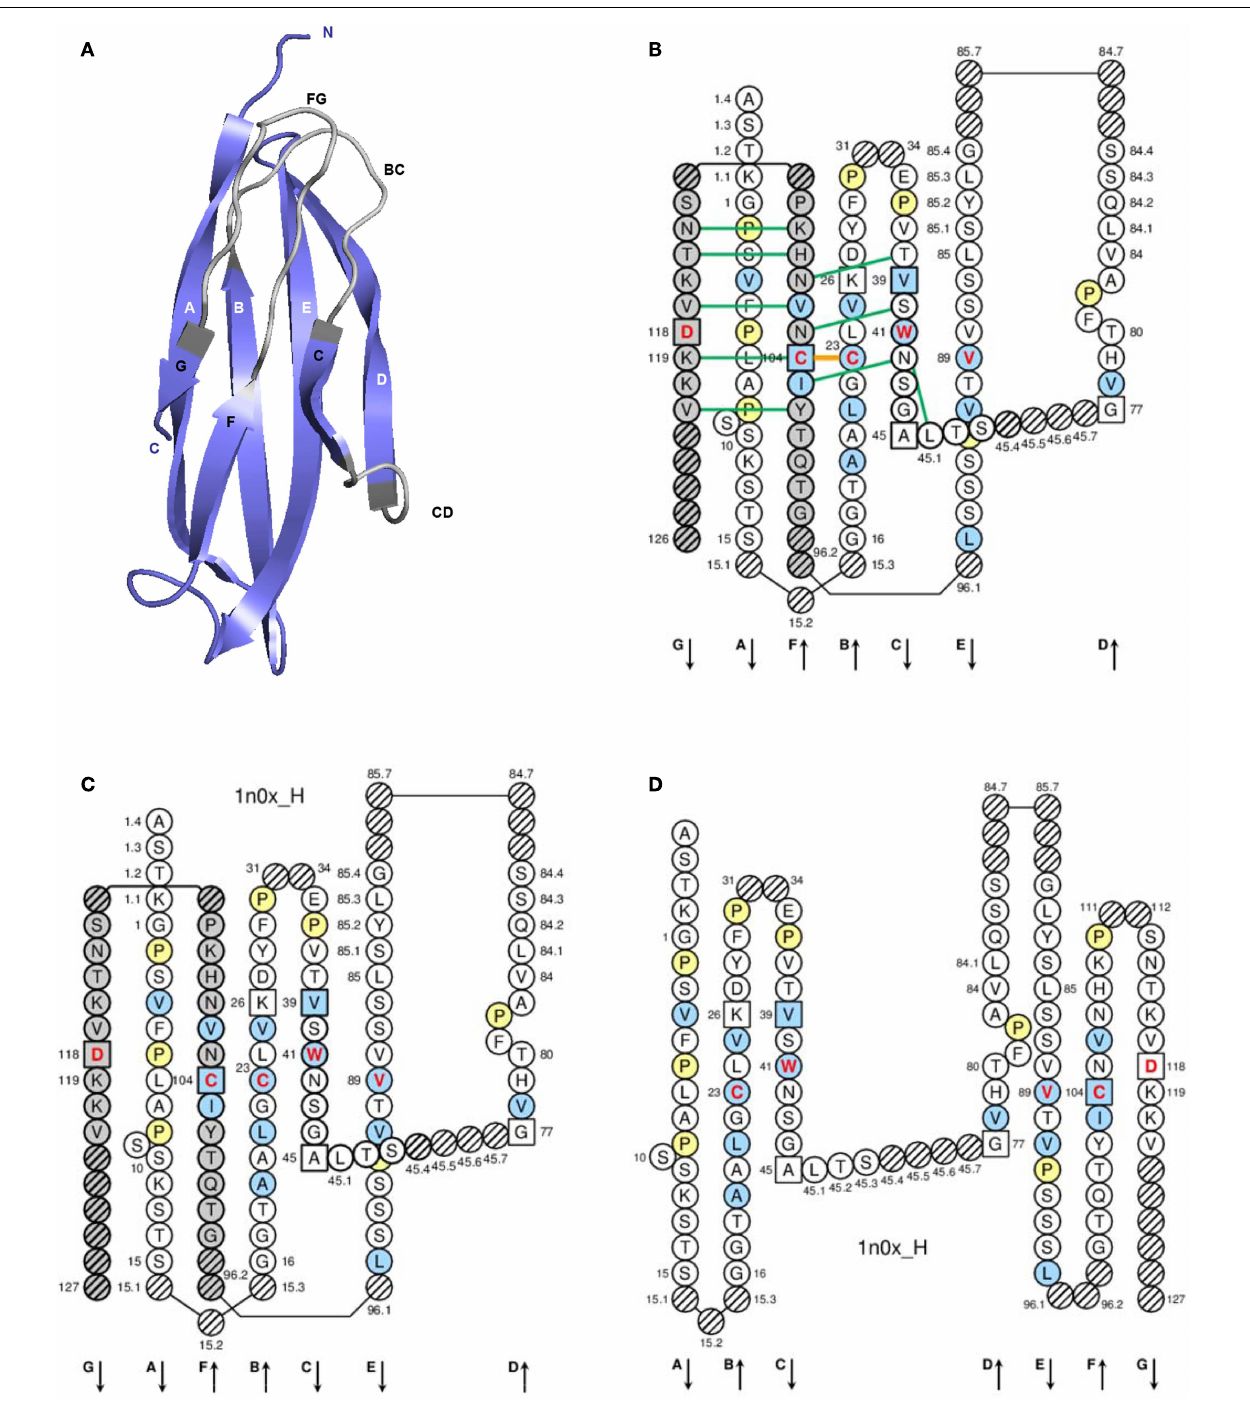
FIGURE 4 | Constant (C) domain . An IG CH (C-DOMAIN) is shown as an example. (A) 3D structure ribbon representation with the IMGT strand and loop delimitations (65). (B) IMGT Collier de Perles on two layers with hydrogen bonds.The IMGT Colliers de Perles on two layers show, in the forefront, the GFC strands and, in the back, the ABED strands (located at the interface CH1/CL of the IG), linked by the CD transverse strand.The IMGT Collier de Perles with hydrogen bonds (green lines online, only shown here for the GFC sheet) is generated by the IMGT/Collier-de-Perles tool integrated in